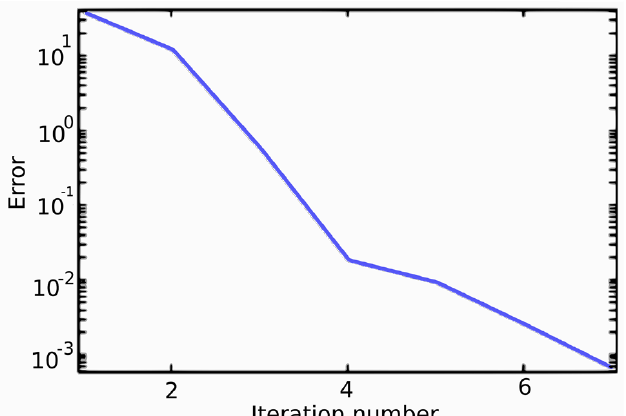
Figure 5. Convergence diagram showing the error estimation in the first iteration of Sierpinski carpet.